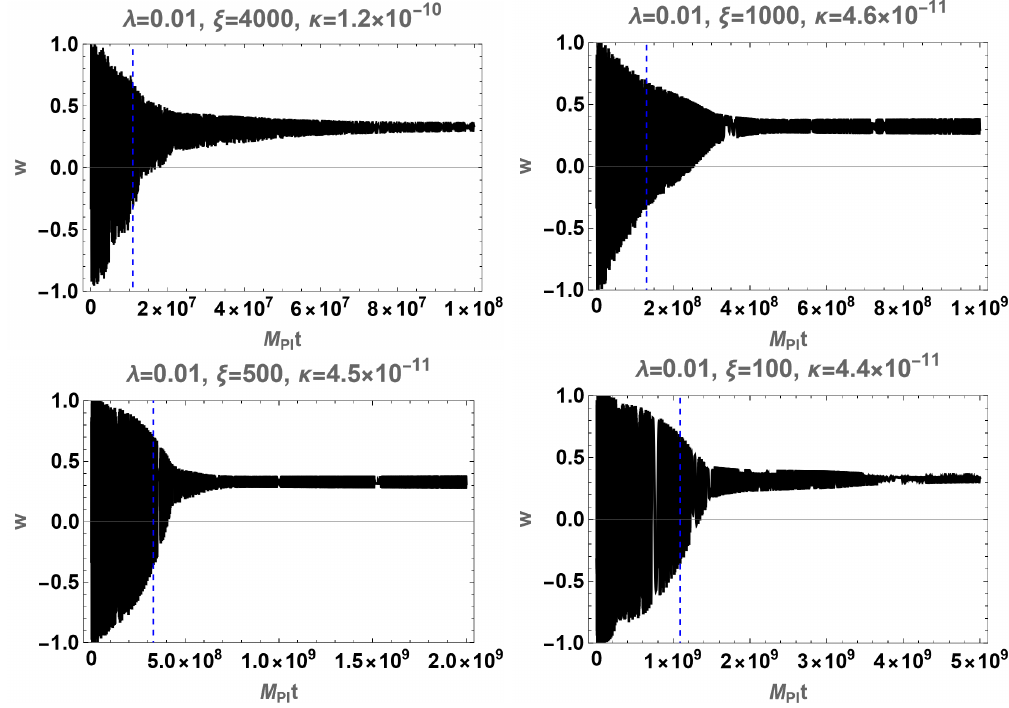
Figure 5 . Time evolution of the equation of state w during reheating. The blue dashed line denotes the time at reheating